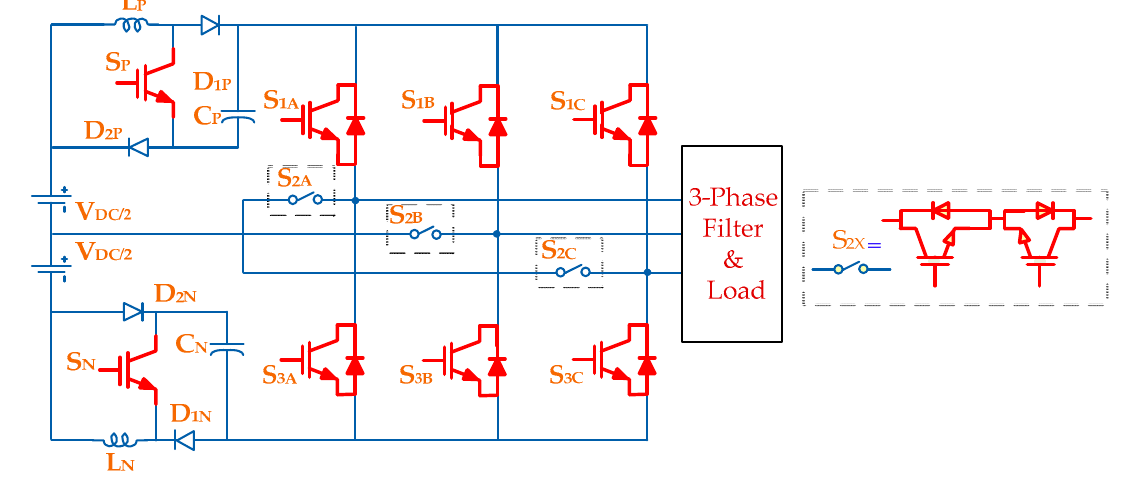
Figure 33. DC-Link qSBI T-Type inverter topology. Table 2. Comparison of quasi-switched boost inverter configurations.